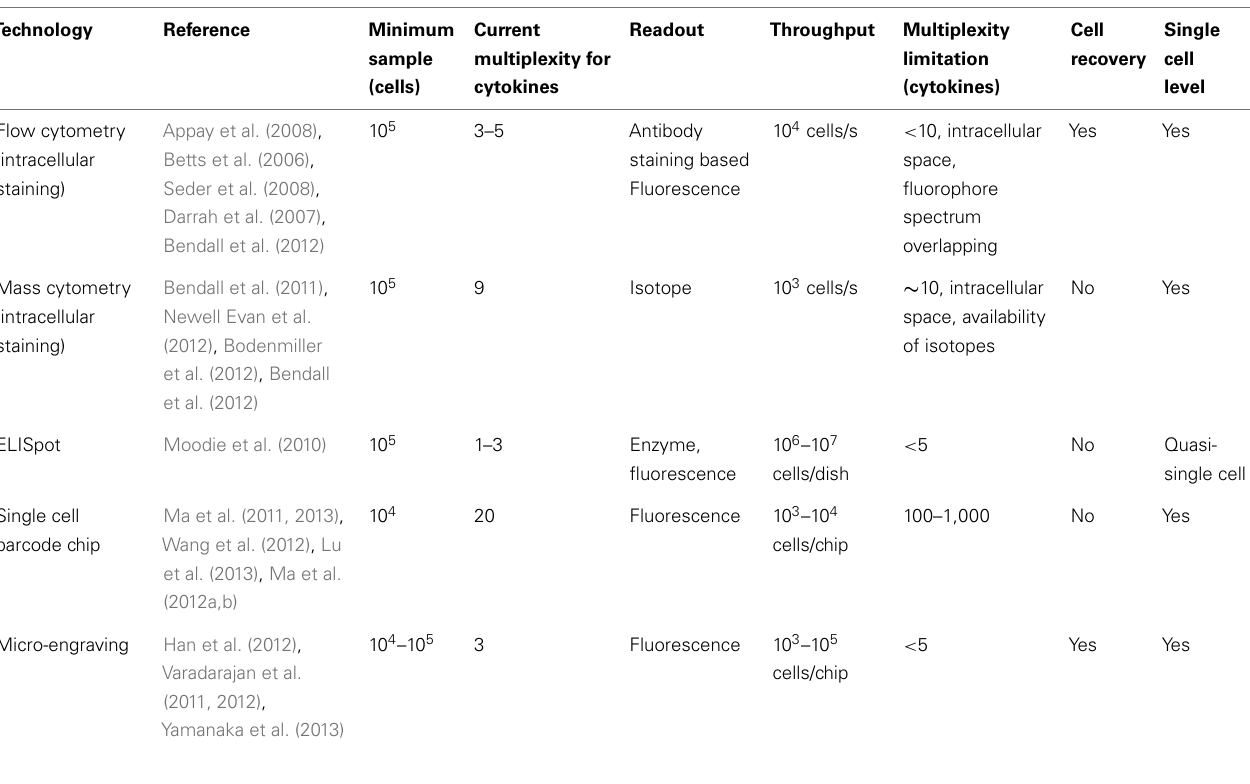
Table 1 | Comparison of existing single cell technologies for profiling functional proteomics.